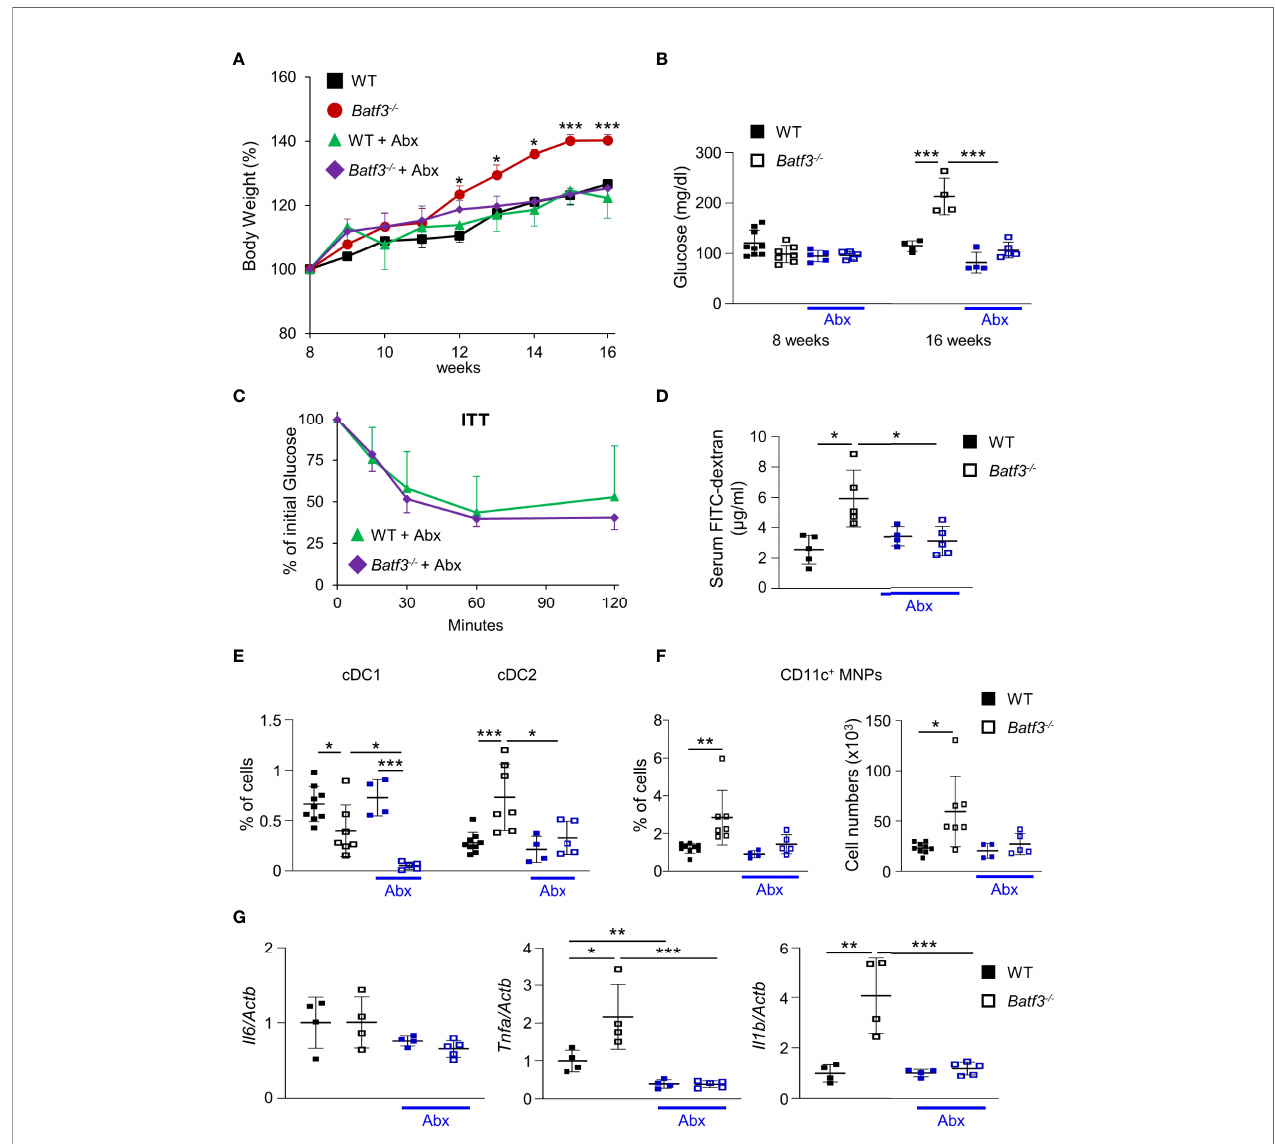
FIGURE 5 | Commensal bacteria contribute to the development of metabolic syndrome in Batf3 -/- mice. (A) Body weight gain as percentage of the initial weight at week 8 (NC: n = 4/genotype; Abx: n = 4-5/genotype). (B) Fasting blood glucose concentrations (NC: n = 4/genotype; Abx: n = 4-5/genotype). (C) Insulin tolerance test (ITT) in WT and Batf3 -/- mice at 16 weeks of age treated with Abx (NC: n = 4/genotype; Abx: n = 4-5/genotype). (D) FITC-dextran serum concentration at 16 weeks of age (NC: n = 4/genotype; Abx: n = 4-5/genotype). (E, F) Percentage of colonic lamina propria cDC1, cDC2 (E) , and CD11c + MNPs, percentage of cells (left panel), total number of cells per large intestine (right panel) (F) measured by fl ow cytometry (NC: n = 4/genotype; Abx: n = 4-5/genotype). (G) mRNA expression of Il1b , Tnfa , and Il6 in the cecum of 16-week-old mice on normal chow, with or without Abx as measured by qPCR. All data were normalized to expression of Actb and represented as fold changes compared to WT mice (NC: n = 4/genotype; Abx: n = 4-5/genotype). Data are represented as means ± SD. Statistical signi fi cance was determined by Student ’ s t -test (A-C, E-G), or Mann-Whitney-U test (D) . * p < 0.05, ** p < 0.01, *** p <